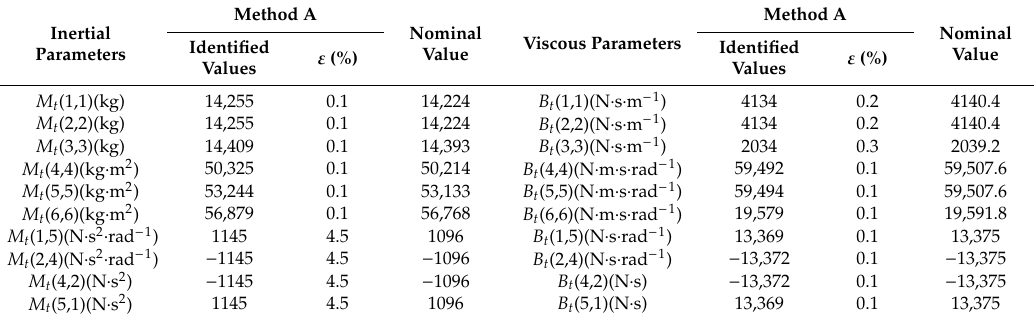
Table 3. Identification results with viscous friction models and identification methods based on Fourier transform.